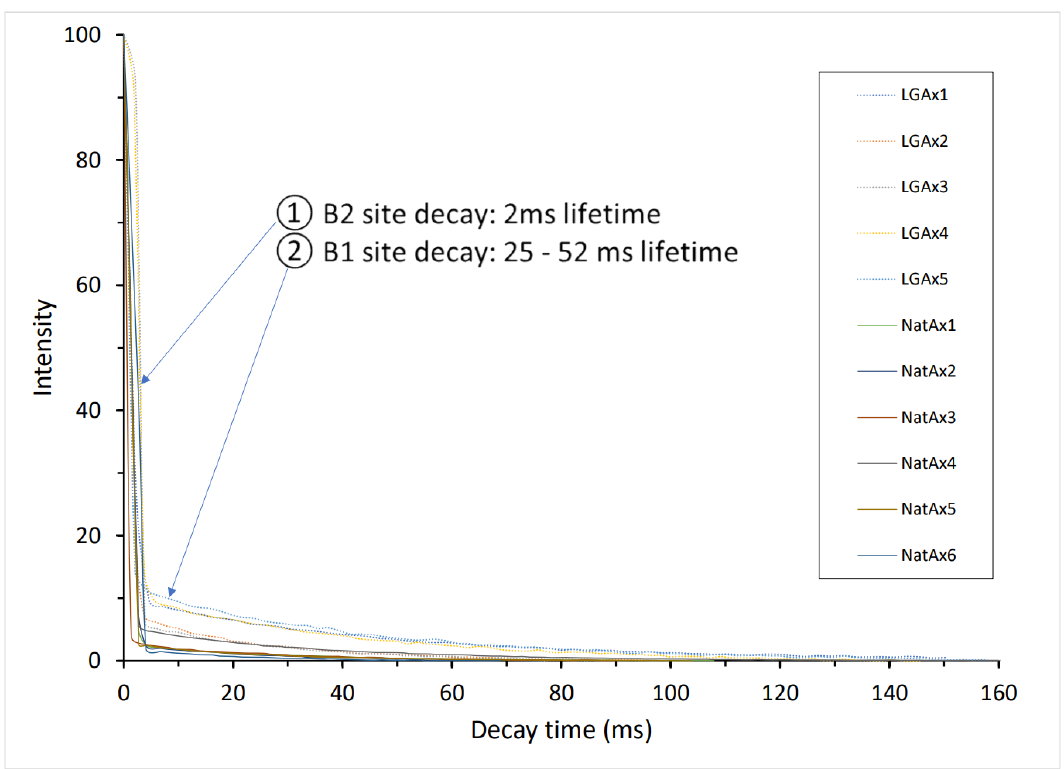
Figure 9. Photoluminescence decay curves at 696 nm of the natural and lab-grown alexandrite samples. Indication of the two decay processes that are related to Cr 3+ in the mirror site (B2) and Cr 3+ in the inverse site (B1). B1 site decays begin with a different intensity of individual samples.